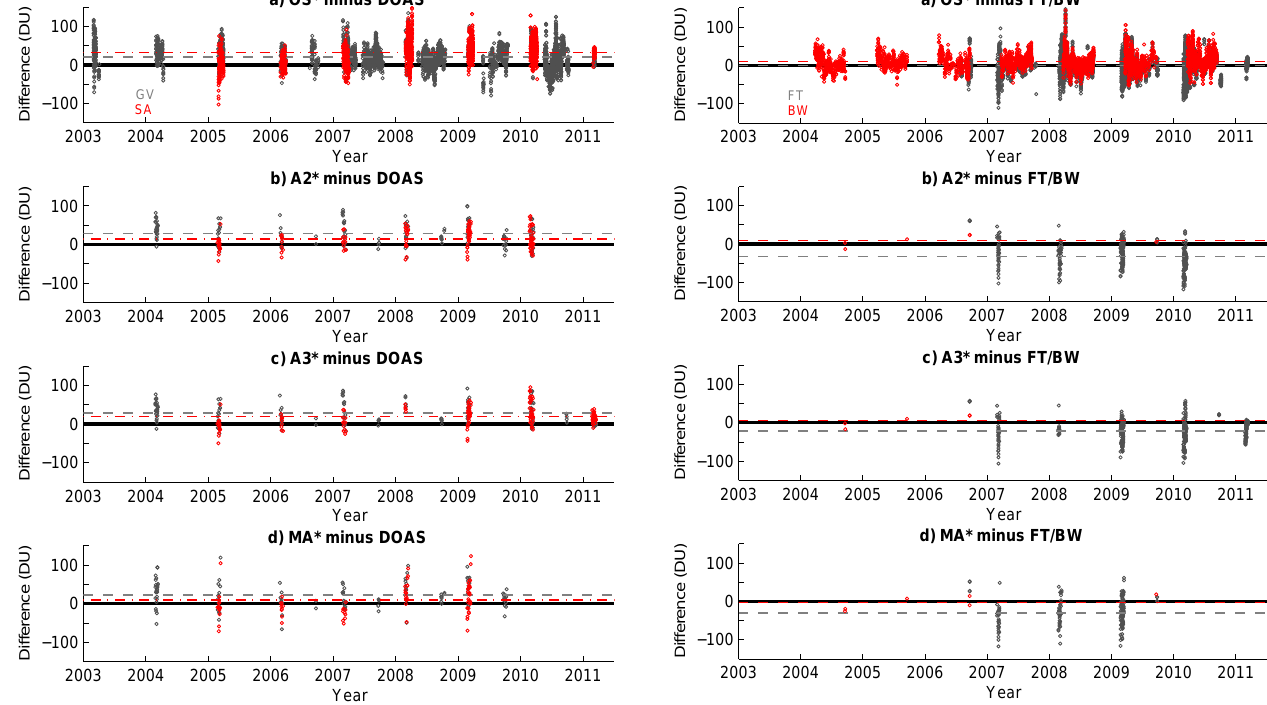
Fig. 7. Absolute differences (circles) and mean absolute differences (dashed lines) between satellite-plus-ozonesonde and GBS (grey) and SAOZ (red). The solid black lines indicate zero.